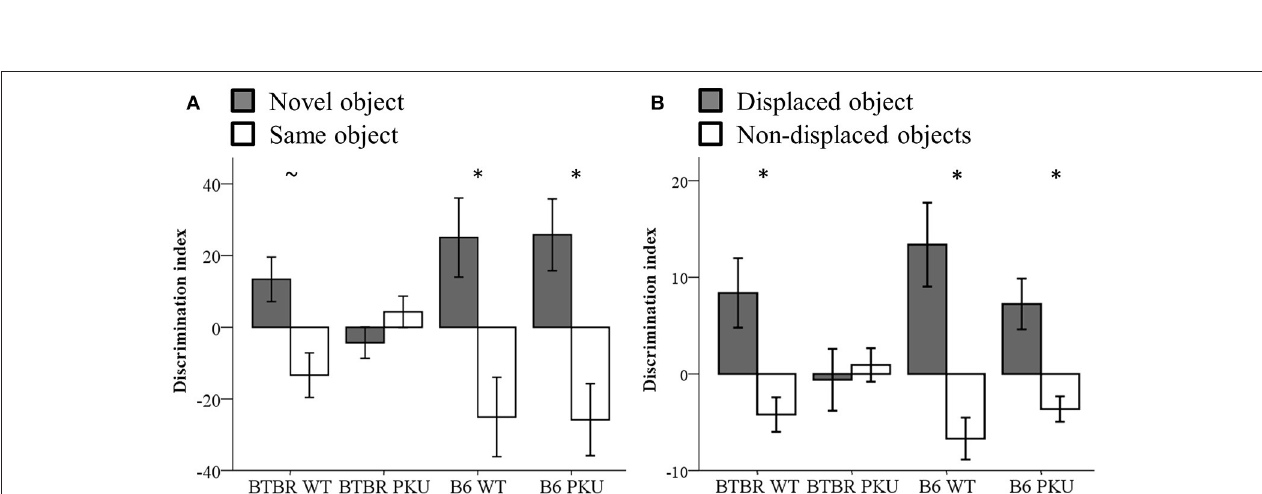
Frontiers in Behavioral Neuroscience | www.frontiersin.org